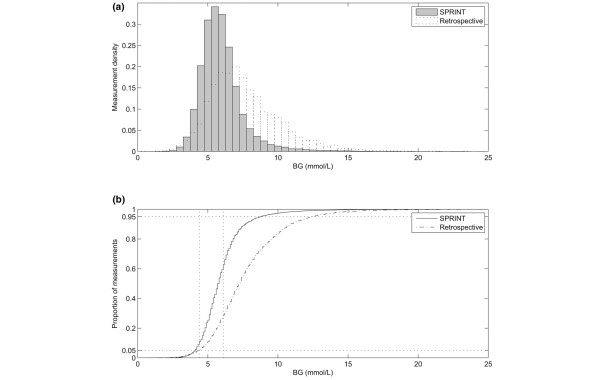
Comparison of distribution of all blood glucose measurements. (a, b) Histogram and empirical cumulative distribution function of all blood glucose measurements for all Specialised Relative Insulin Nutrition Tables (SPRINT) patients (shaded, solid line) and retrospective cohort patients (dashed line), respectively. BG, blood glucose concentration.